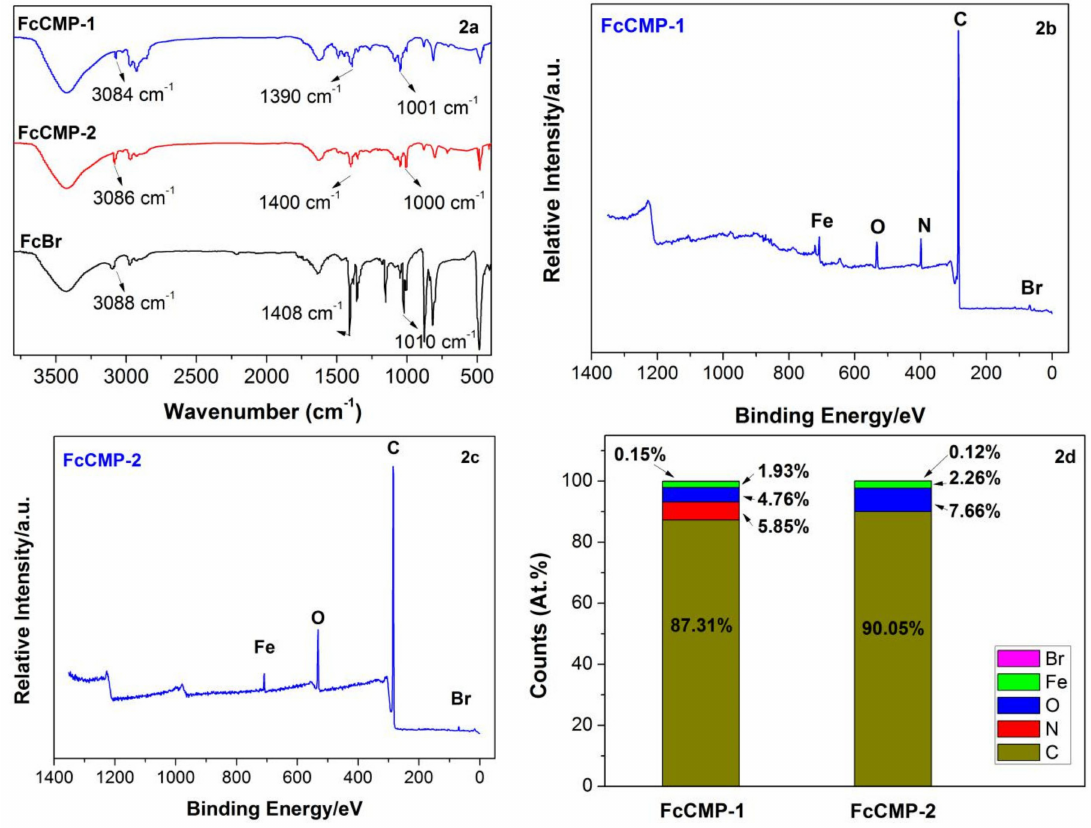
Figure 2. FT-IR spectra, XPS spectra, and element distribution images of FcCMP-1 and